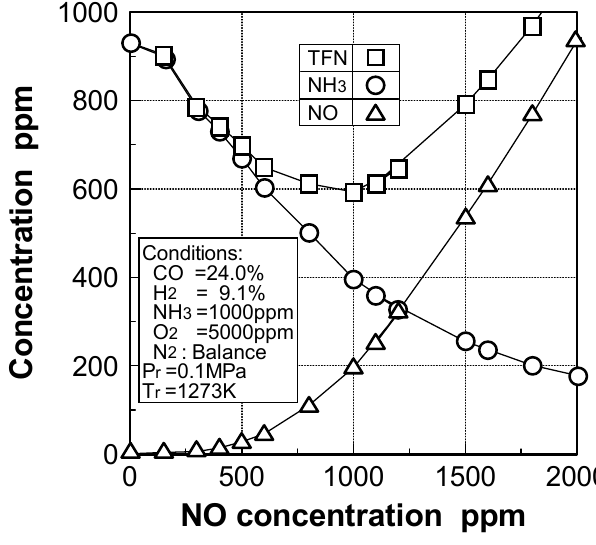
Figure 31. Effect of NO concentration on decomposition of NH gasified fuel as defined by